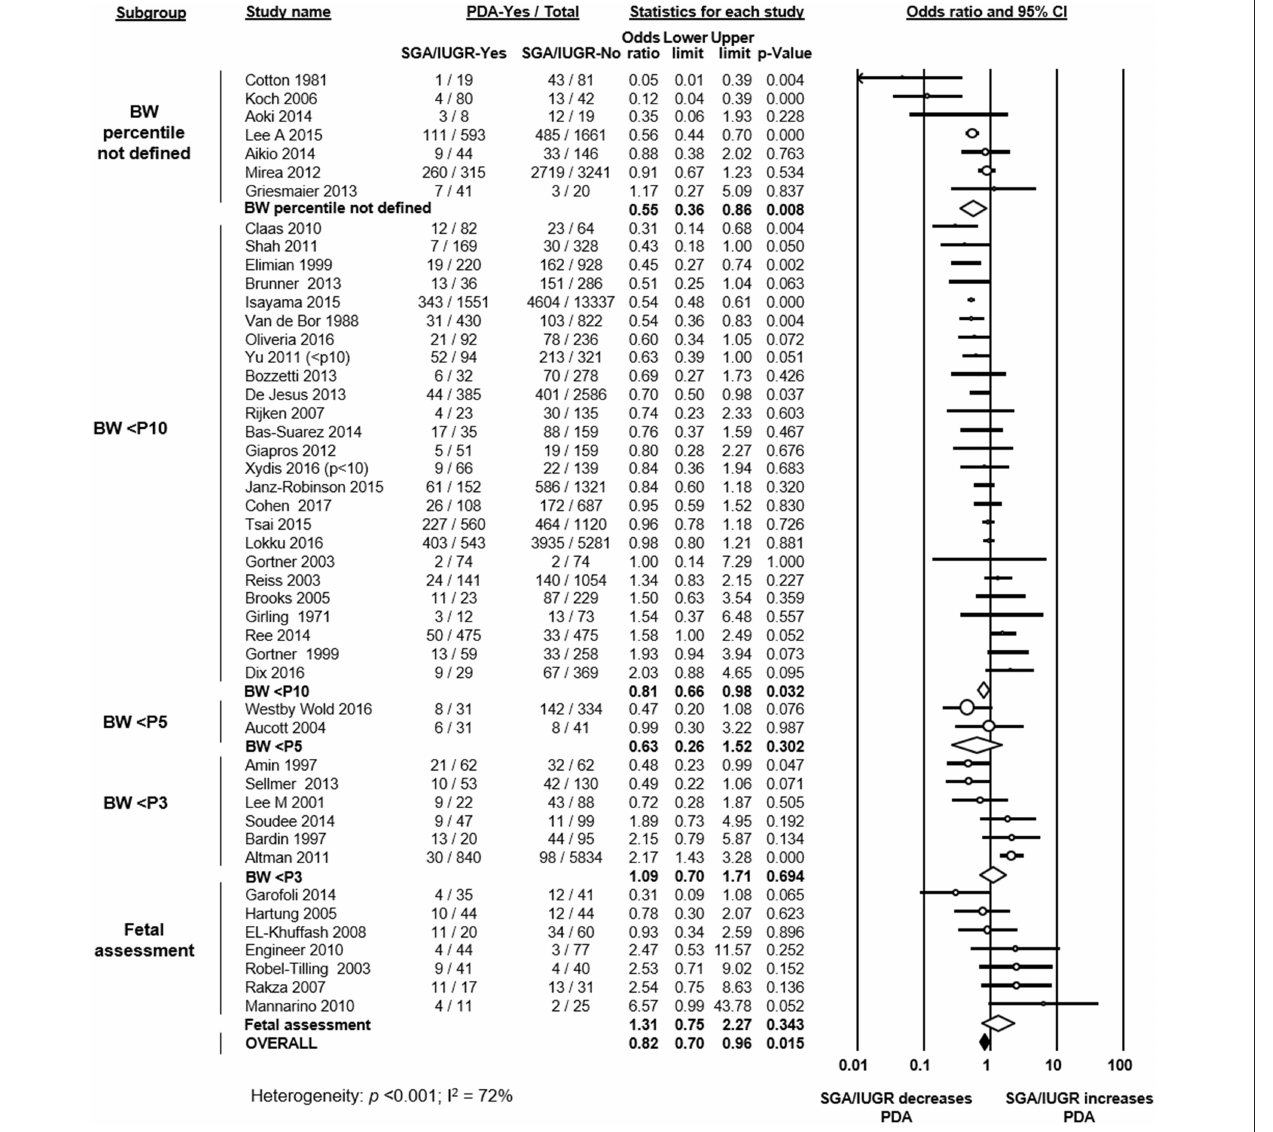
FIGURE 1 | Meta-analysis of the association of small for gestational age (SGA)/intrauterine growth restriction (IUGR) and patent ductus arteriosus (PDA). CI: confidence interval; BW: birth weight; < P10: BW lower than 10th percentile; < P5: BW lower than 5th percentile; < P3: BW lower than 3rd